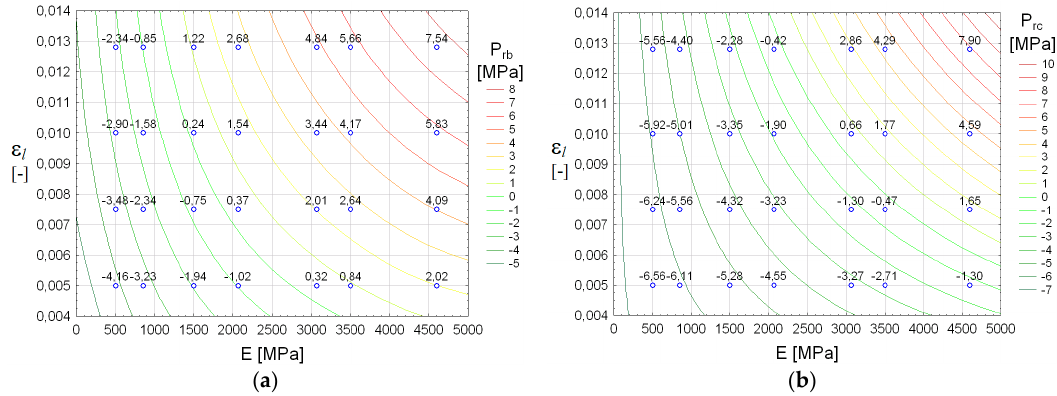
Figure 16. The variability in P rb and P rc as a function of the pressure P L for the coal from the Mannville Group basin, Lower Cretaceous, Western Canada.